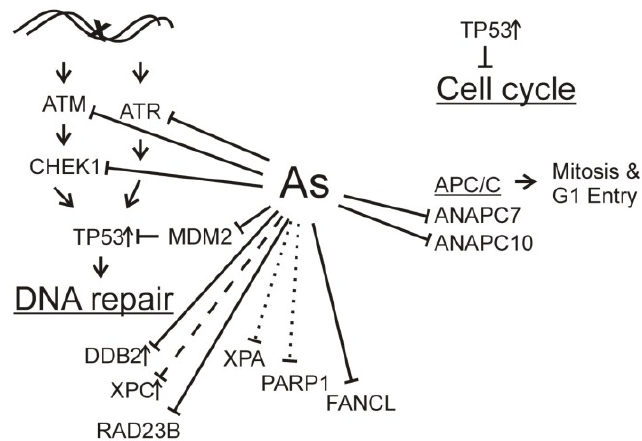
Figure 1. Arsenic inhibition of DNA damage response. DNA damage normally leads to activation of signaling kinases converging through TP53 stimulating DNA repair gene expression and inhibition of cell cycle. Arsenite inhibits transcription (solid lines) of signaling kinase genes (ATM, ATR, CHEK1), MDM2, and downstream DNA repair genes DDB2 and RAD23B. Expression of XPC also is inhibited by arsenite (dashed line), as is function of XPA and PARP1 by displacing zinc from the zinc fingers in these proteins (dotted lines). These effects likely contribute to decreased nucleotide excision